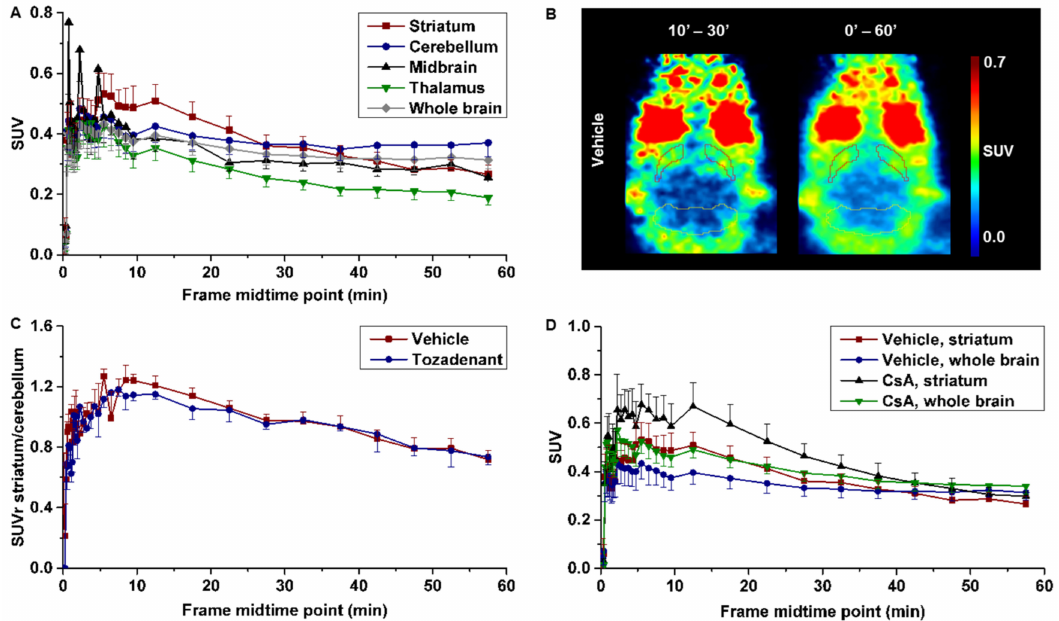
Figure 8. ( A ) Time–activity curves (TACs) of CD-1 mice in different brain regions after injection of [ 18 F] TOZ1 ( n = 7); ( B ) represen- tative horizontal positron emission tomography (PET) images after pre-treatment with vehicle; ( C ) TACs of standardized uptake value ratio (SUVr) of striatum-to-cerebellum after pre-treatment with vehicle ( n = 7) or tozadenant (2.5 mg/kg, n = 3); and ( D ) TACs after pre-treatment with vehicle ( n = 7) or cyclosporine A (CsA, 50 mg/kg, n = 4). Mean SUV ±